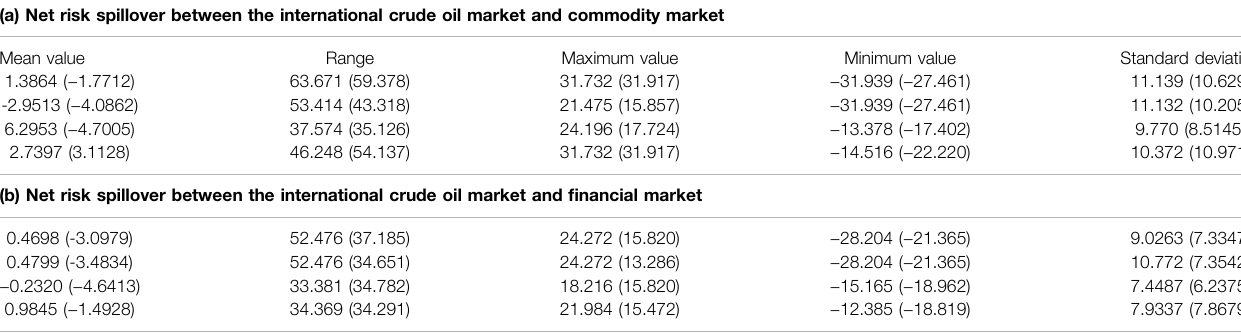
TABLE 5 | Net pairwise risk spillover indexes between the international crude oil market and other markets. (a) Net risk spillover between the international crude oil market and commodity market Mean